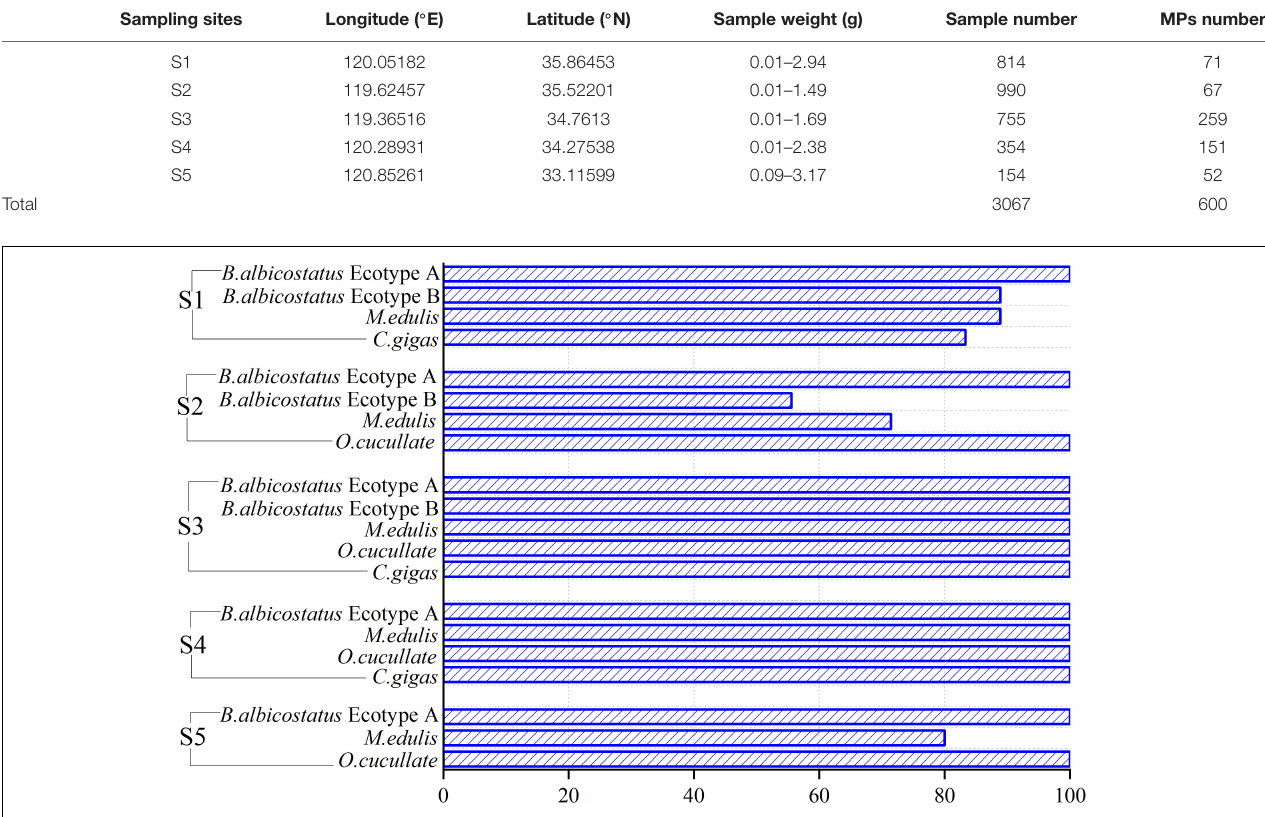
TABLE 1 | Sampling station information summary.